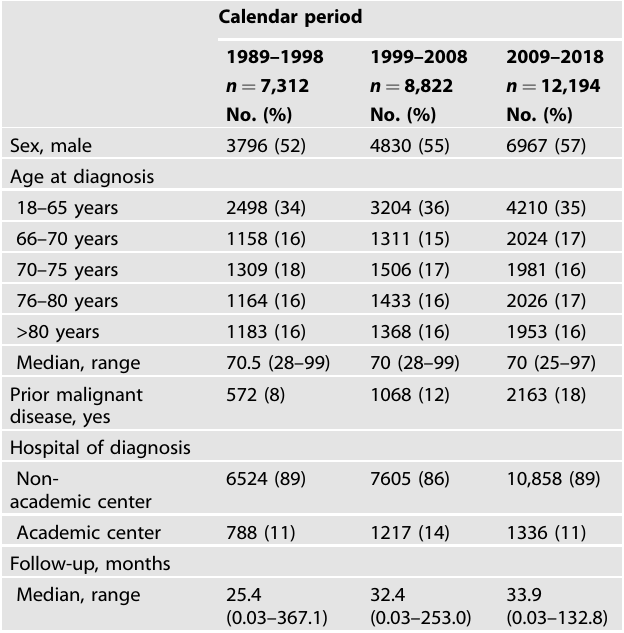
Table 1. Baseline characteristics of patients diagnosed in 1989 – 2018 in the Netherlands, strati fi ed by calendar